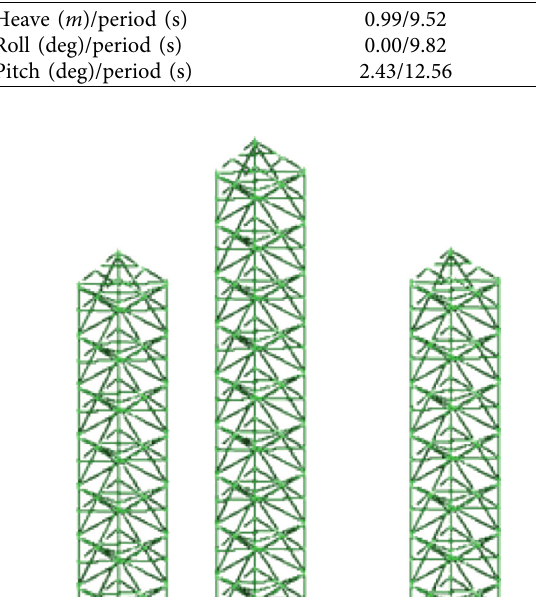
� 9.5s and associated motion periods for different wave incident angles. p